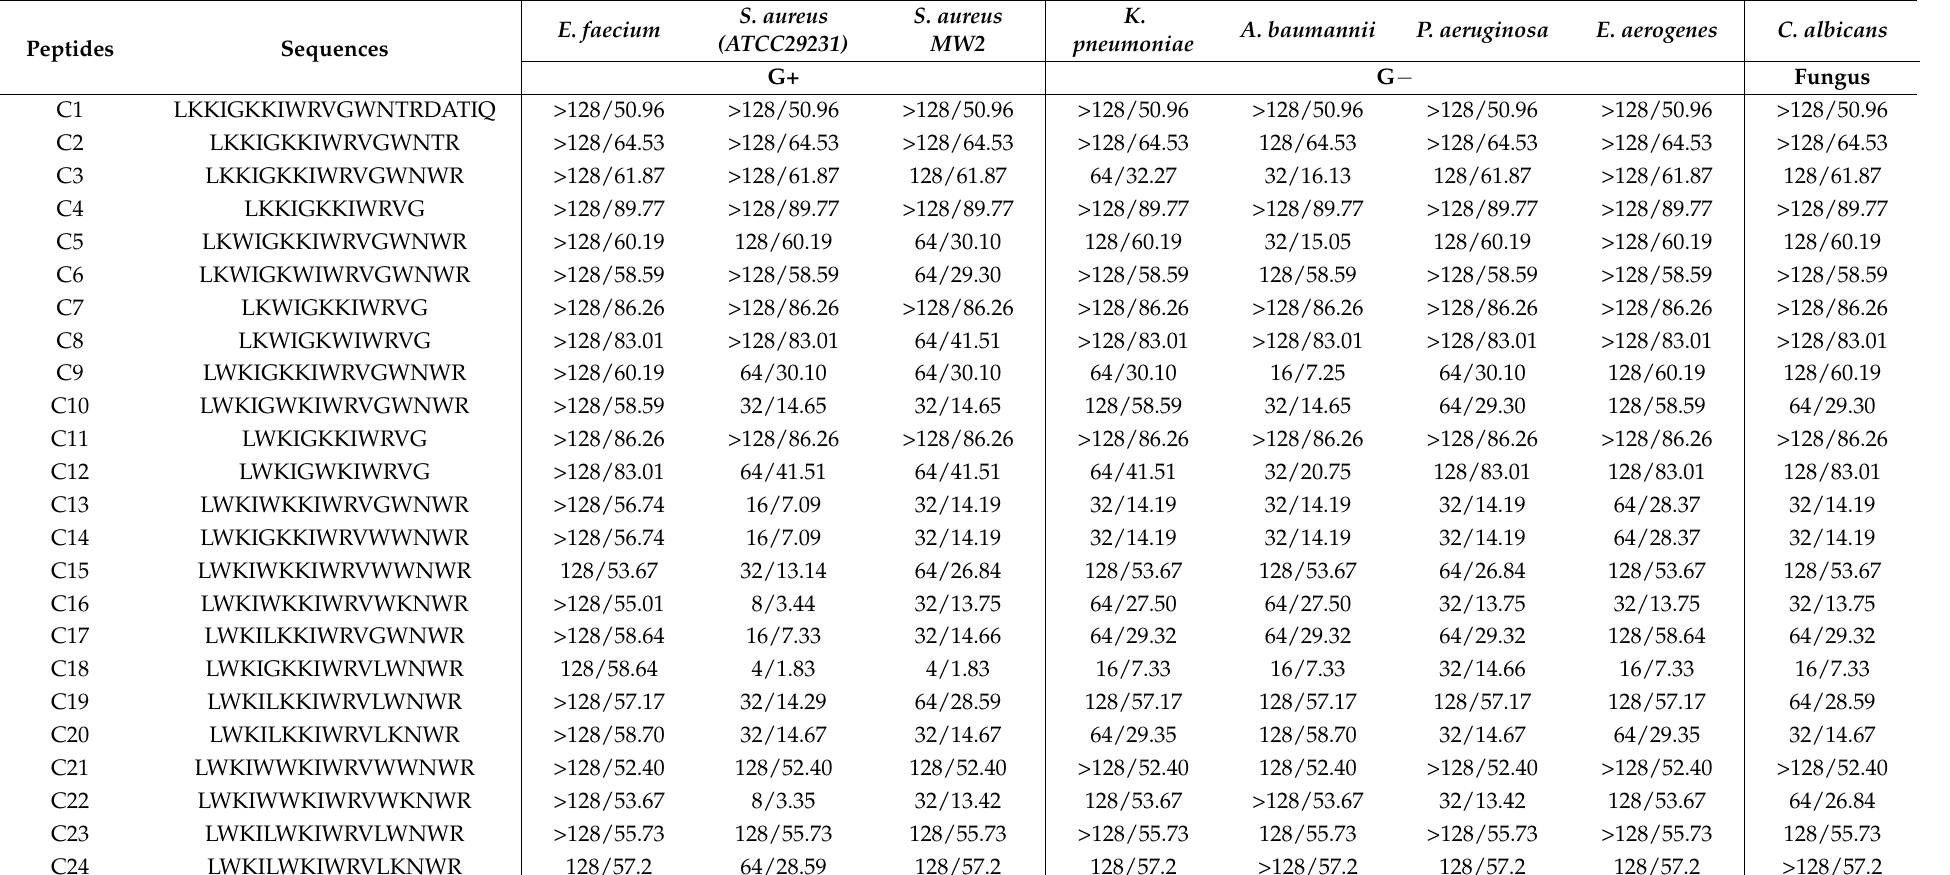
Table 1. Minimal growth inhibition concentrations (MICs) of Cec4-derived antimicrobial peptides (AMPs) against tested microorganisms ( µ g/mL, µ M).